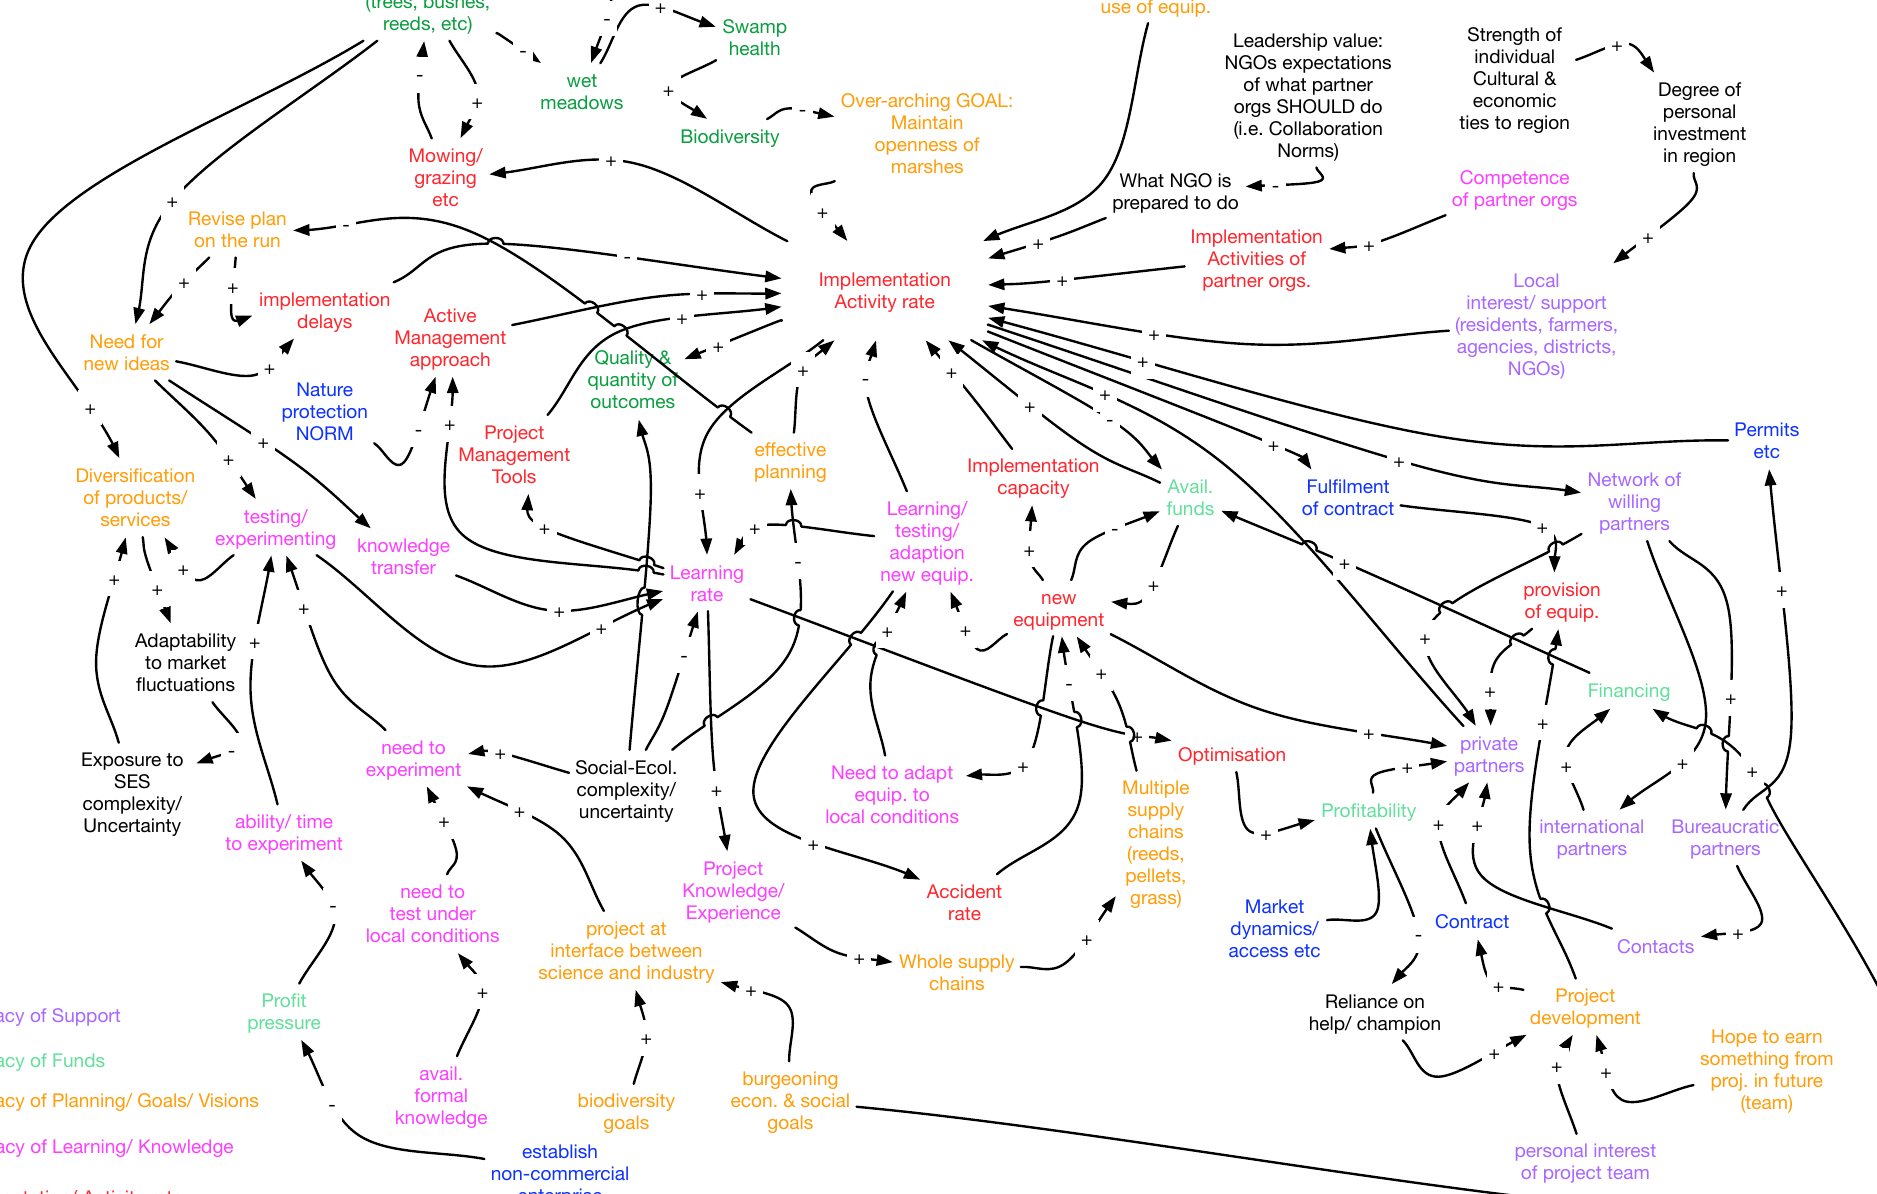
Figure A2:9. Case Birds, Theme: Implementation, activity